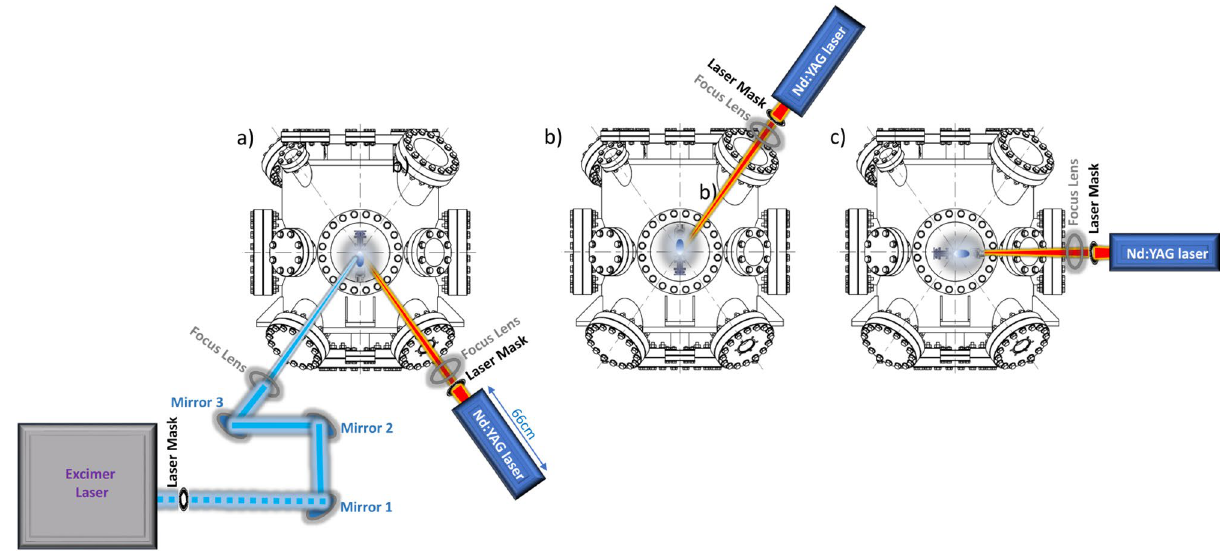
Figure 1. Schematic representation of our PLD system equipped with the Nd:YAG laser, laser mask, and focus lens ( a ) (typical laser-path of KrF excimer laser is also shown; other possible geometrical configurations of the laser head positioning ( b and c